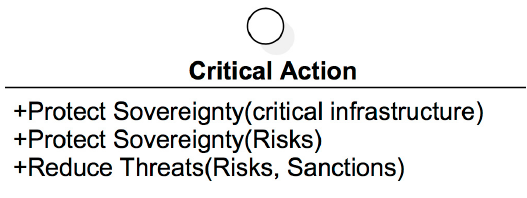
Figure 18. State critical actions.